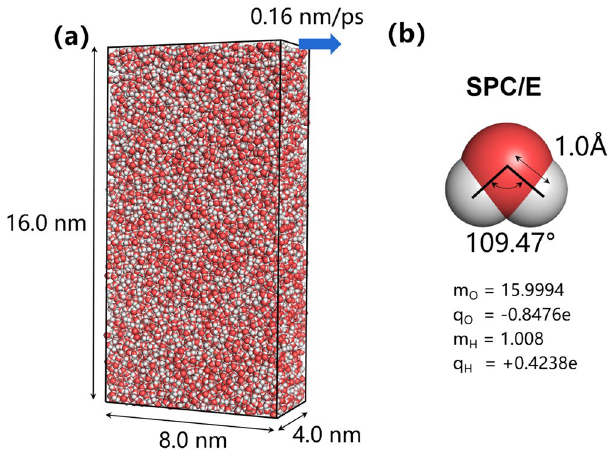
Figure 7. Schematics of the system model ( a ) and water model ( b ). ( a ) The system includes 17,314 water molecules. The shearing velocity is 0.16 nm/ps along x direction. ( b ) The geometry of SPC/E water model. The pictures are both drawn by VMD 1.9.1 63